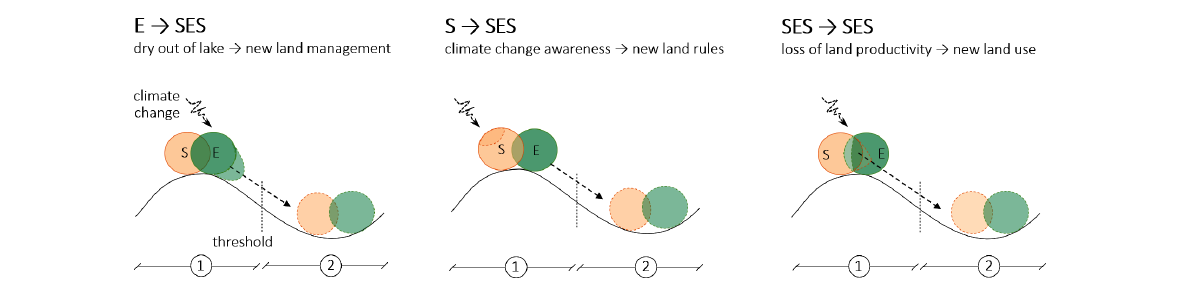
Fig. 1 . Three ways in which a social-ecological system (SES) can undergo a shift in its trajectory (from state 1 to 2) due to climate change and other stress, with examples. Climate change can induce changes in either the ecological (E) or the social (S) subsystem that drive the entire social- ecological system across a threshold (E → SES and S → SES, respectively). Climate change can also directly impact the interactions between social and ecological systems and push the entire social-ecological system across a threshold (SES →